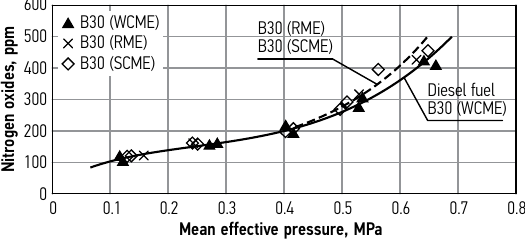
Fig. 7. The dependence of exhaust gas temperature t tpir of 1Z diesel engine on mean effective pressure P me